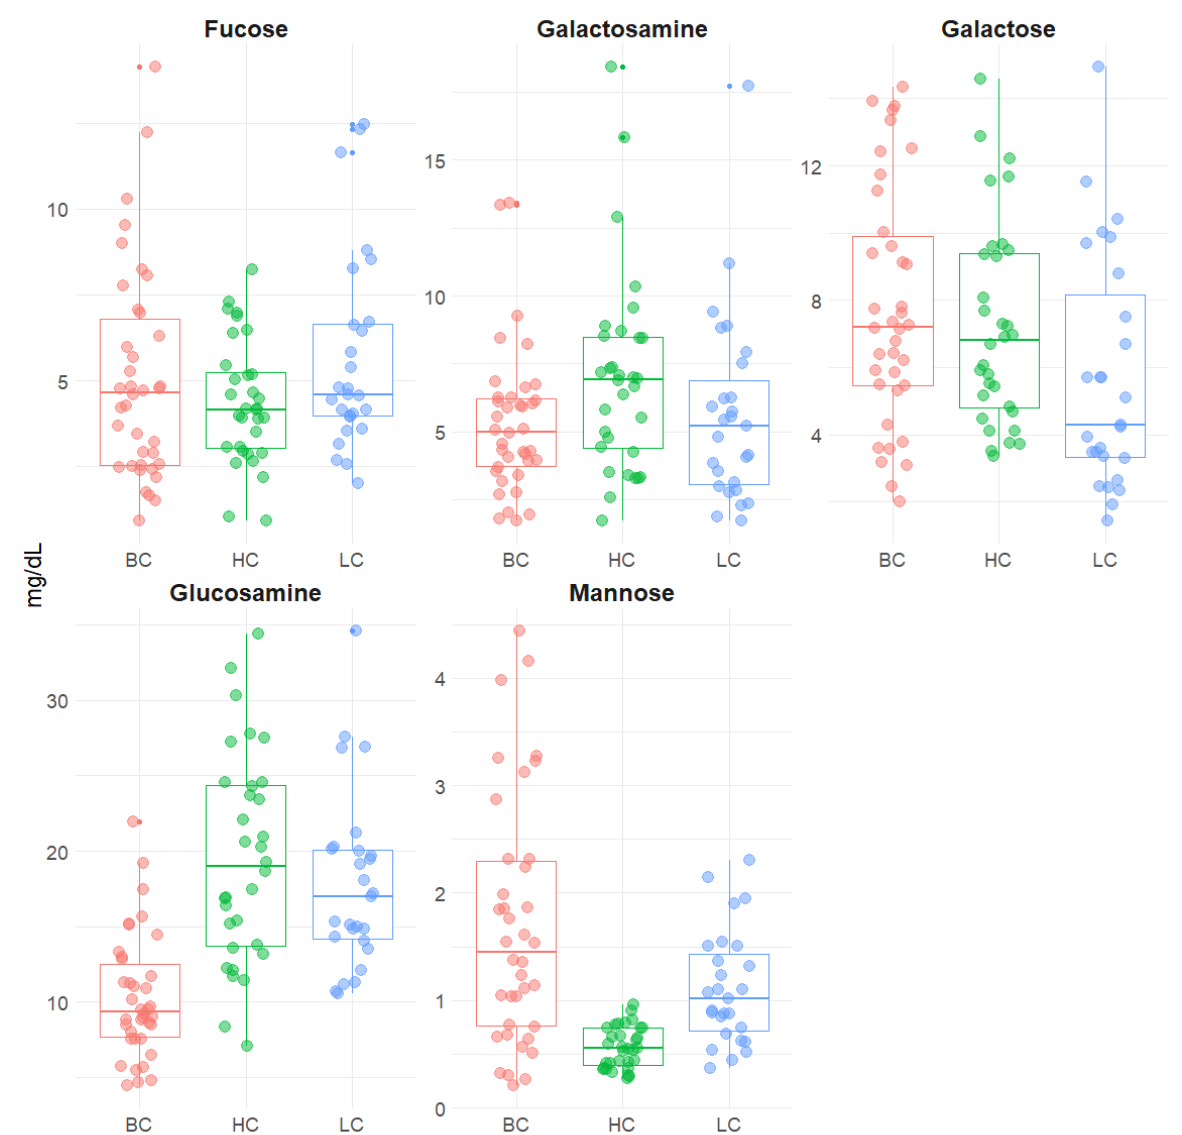
Figure 2. Dot plots reporting the concentrations of the hydrolyzed carbohydrates from saliva samples of patients with breast cancer (BC), lung cancer (LC), or healthy controls (HC).